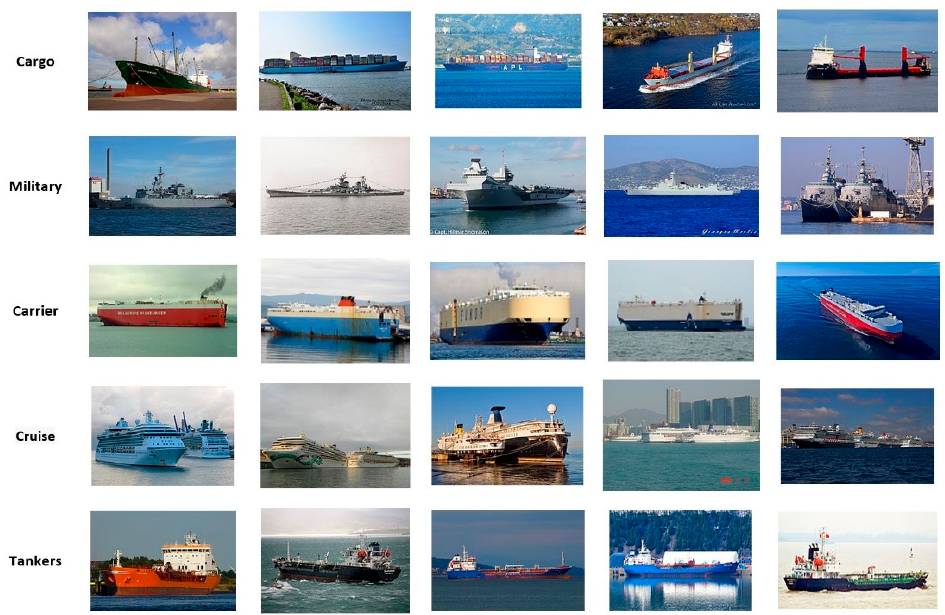
Figure 2. Selection of random ship images from the dataset.